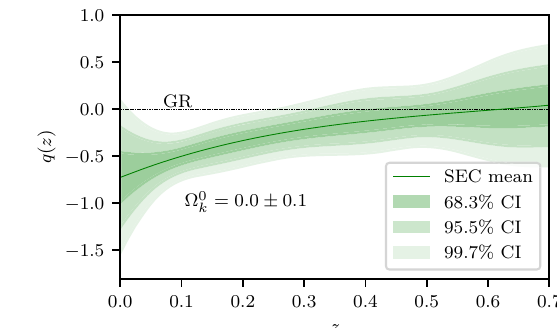
studied,whereastherightpainelcomprehends z ∈ [ 0 , 0 . 8 ] highlighting the strongest violated region. This MCMC result was obtained using a with zero mean and σ = 0 . 1 Gaussian prior on Ω 0 k